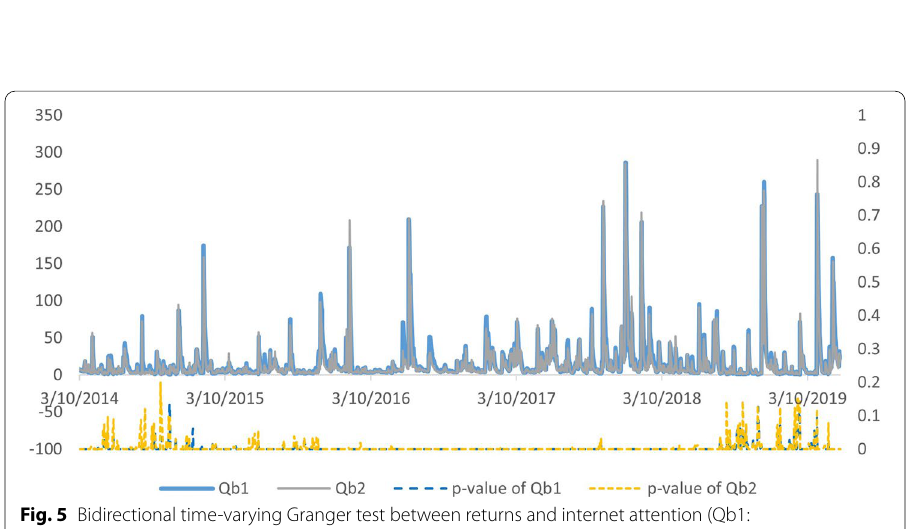
Fig. 5 Bidirectional time-varying Granger test between returns and internet attention (Qb1: returns < > GSVI; Qb2: returns < > = =